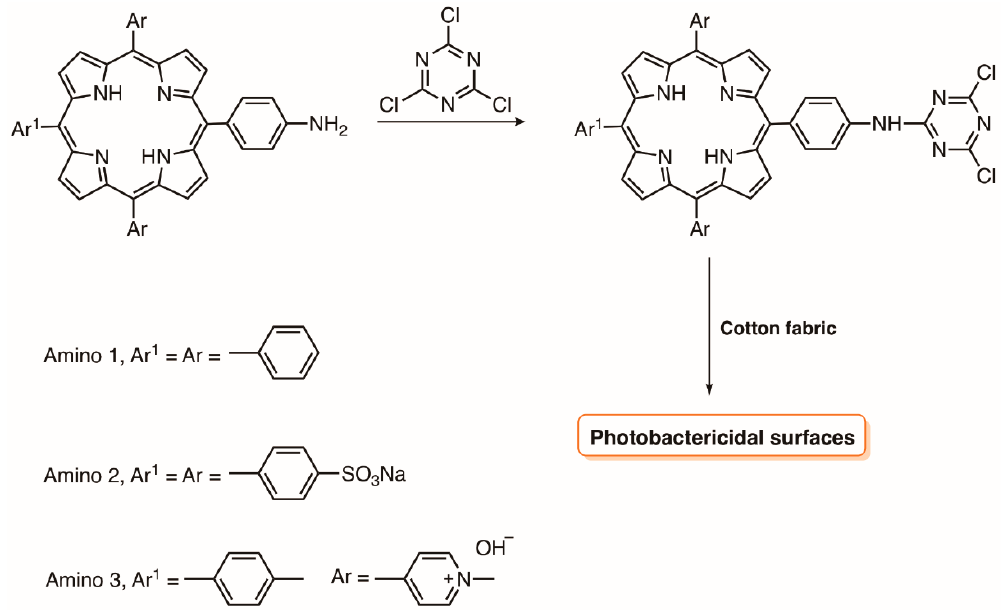
Figure 24. Synthetic methodology used to covalently graft the amino porphyrins 2-4 on cotton fabrics via 1,3,5-triazine linker (adapted from Reference [131]).